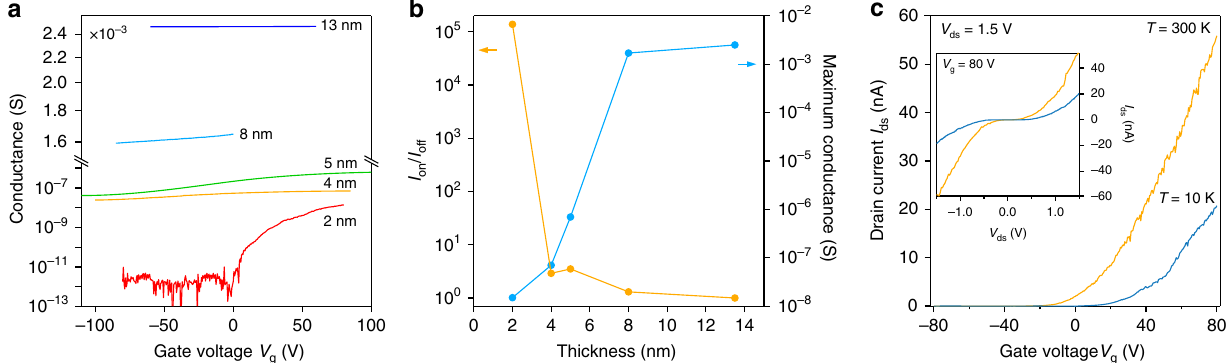
Fig. 3 Thickness modulation of transport in PtSe 2 . a Conductance modulation as a function of gate voltage for different sample thicknesses. b Maximum conductance and on/off ratio as a function of sample thickness at 10 K. c I ds − V g curves recorded for the 2 nm thick device, showing n-type semiconducting behavior. Inset: I ds − V ds curves recorded for the same device